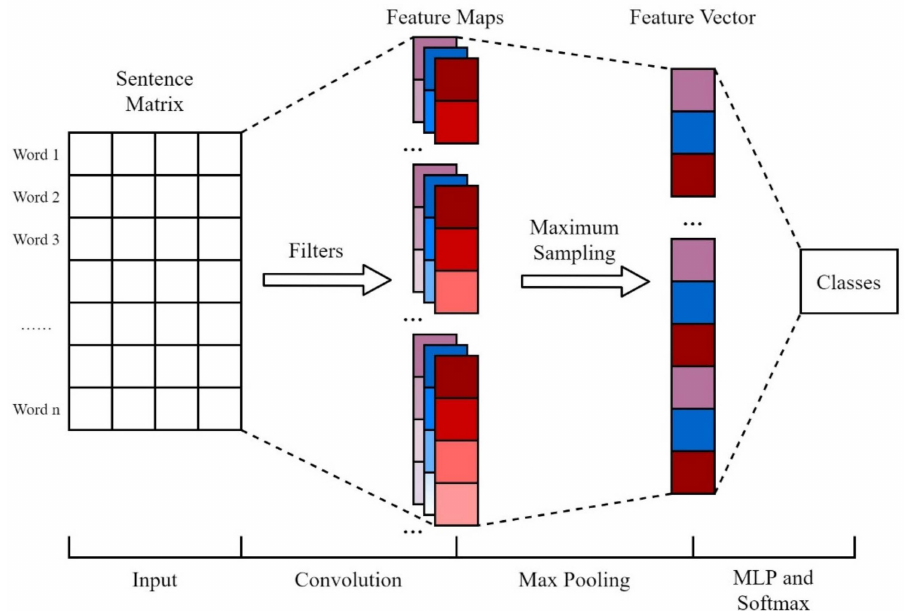
Figure 2. The structure of CNN text classification model used in this